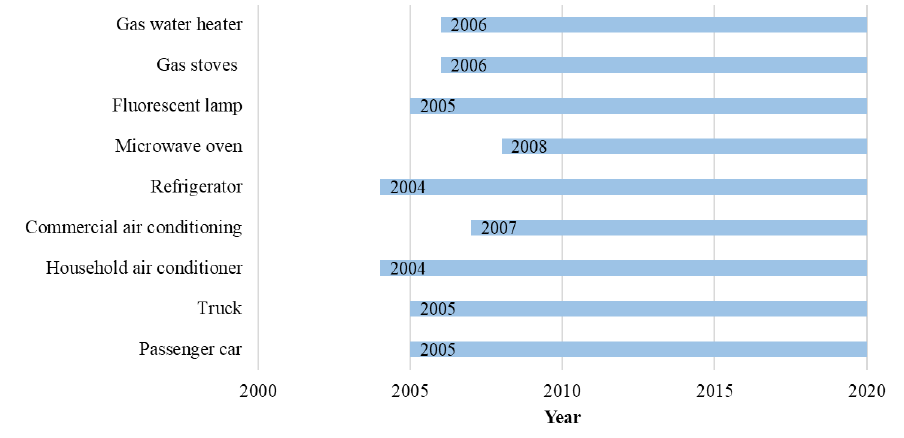
Figure 4. Assessment starting year of different equipment.